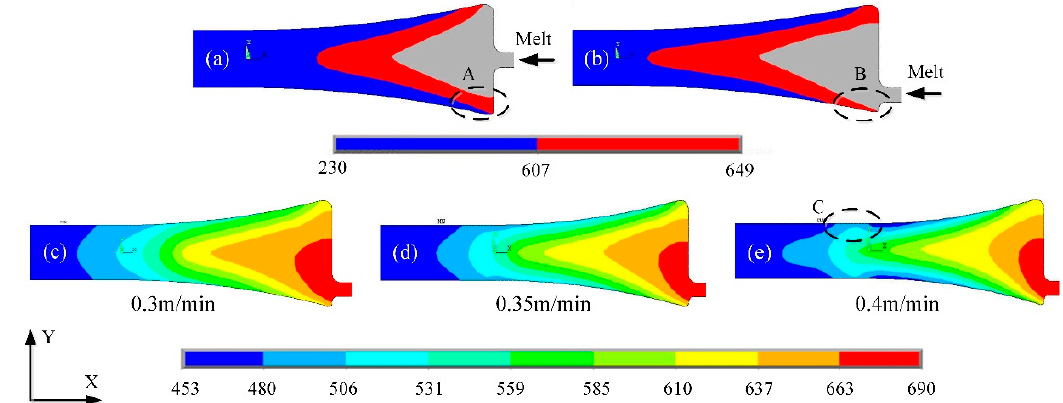
Figure 3. Simulation of temperature field in cast-rolling zone under different processing conditions: ( a ) aluminum melt is supplied in the middle of the nozzle, ( b ) aluminum melt is supplied in the lower part of the nozzle, ( c – e ) temperature field in cast-rolling zone under different cast-rolling speed.